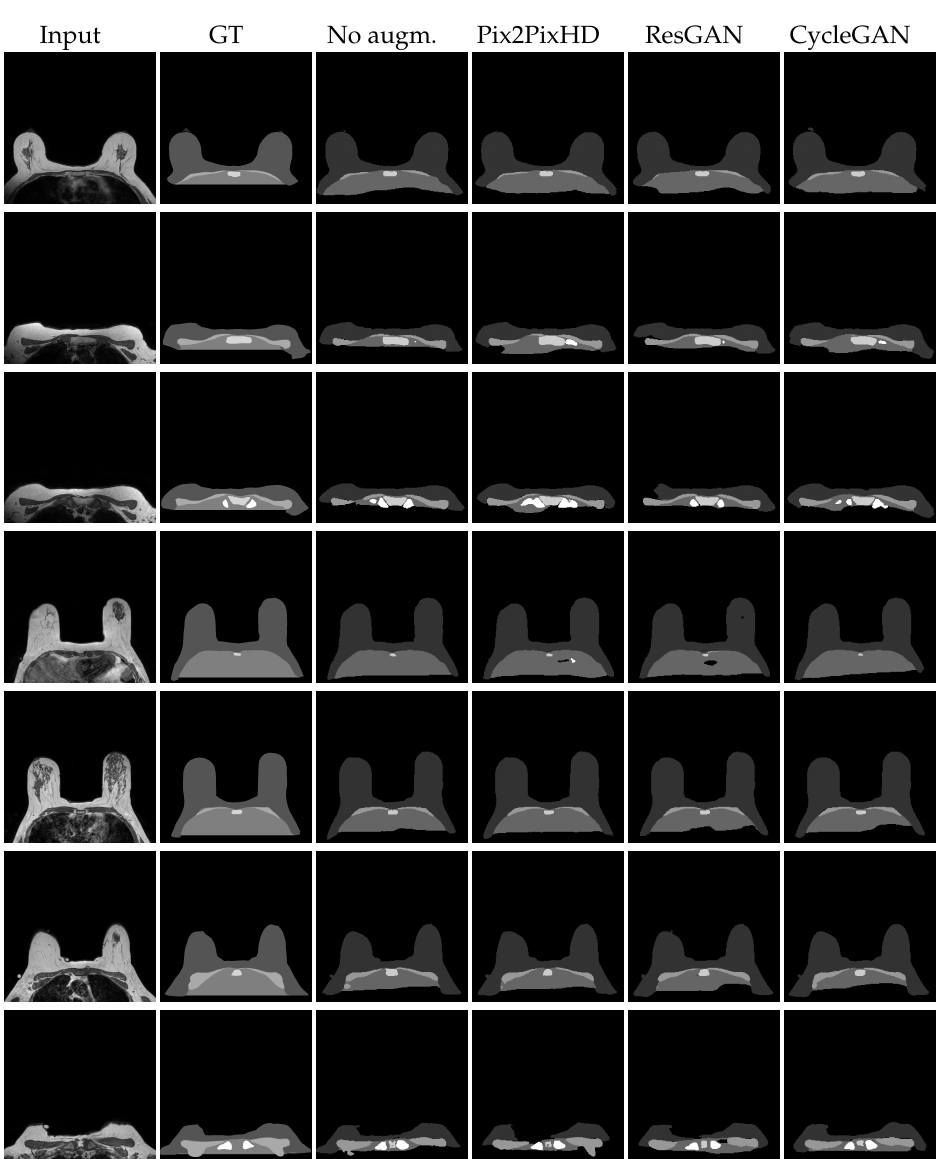
Figure A4. Further best visual test results for the segmentation U-Net, trained with the respective synthsets ResGAN and Pix2PixHD with BS8. CycleGAN with BS1 and Experience Replay. Part